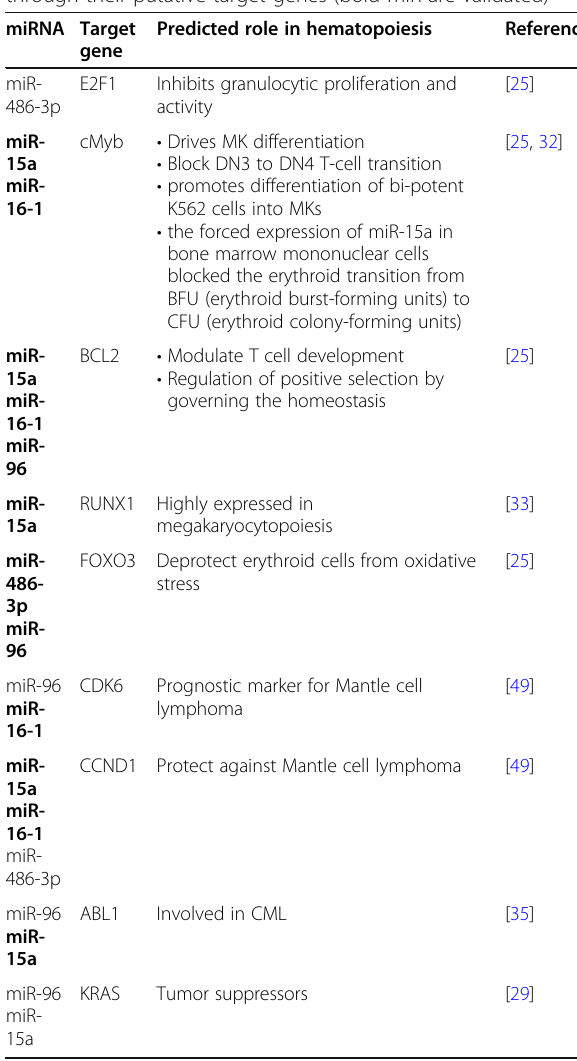
Table 3 The expected role of the miRNAs in hematopoiesis through their putative target genes (bold miR are validated) miRNA Target Predicted role in gene